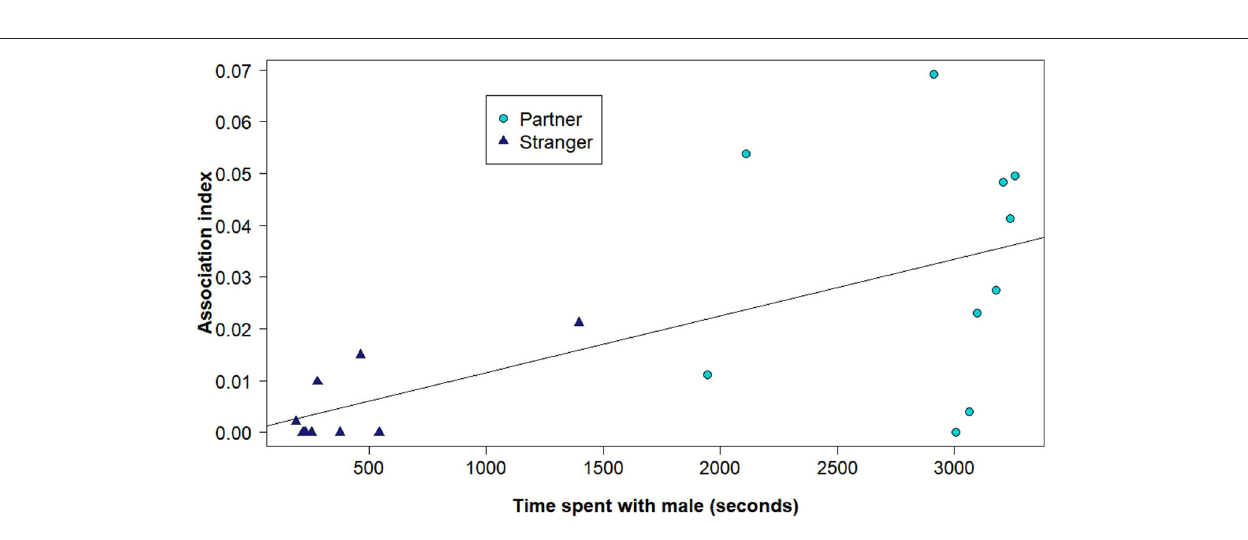
FIGURE 3 | The time that the focal female spent with each male during the partner preference test (with a possible maximum of 3,600s) and the corresponding association index of that pair based on the social network analyses using the RFID system. The points representing either the potential partners or the potential strangers from the partner preference trials are represented as different shapes and